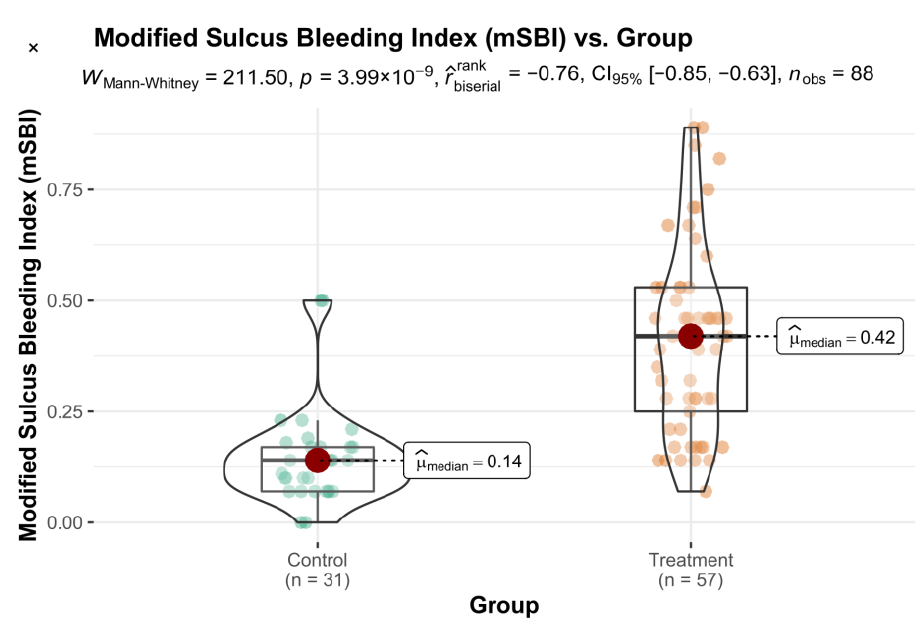
Figure 2. Modified Sulcus Bleeding Index vs. Group variable with differences in means statistical reporting.